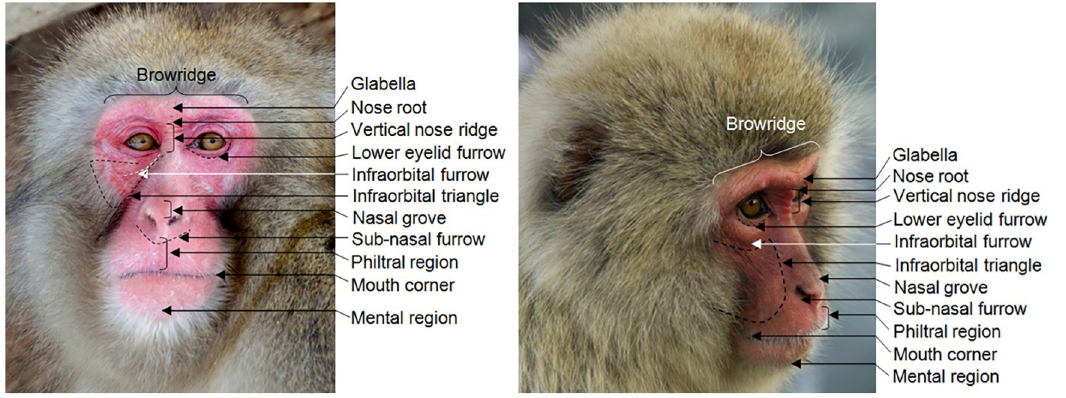
Fig 2. Facial landmarks in Japanese macaques in frontal and profile view. The Japanese macaque has a longer and more prognathic face than rhesus macaques, with lower intra-ocular distance. The ears tend to be more covered with hair. In some individuals, the browridge may be more salient